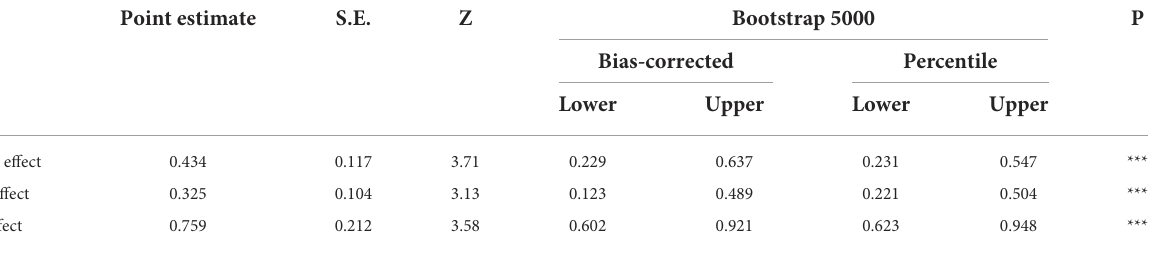
TABLE 6 Significance analysis of the mediation effect. Paths Point